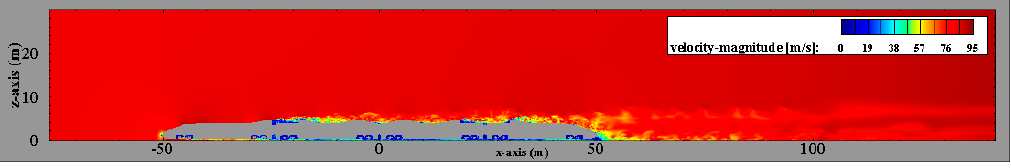
( b ) Figure 7. Instantaneous static pressure contour: ( a ) x–z plane, y = 0 m; ( b ) x–y plane, z = 1 m.